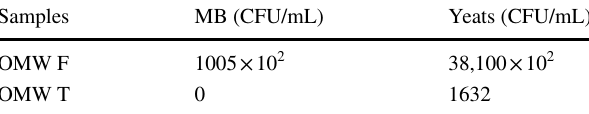
(+) Bacterial growth observed and (−) No bacterial